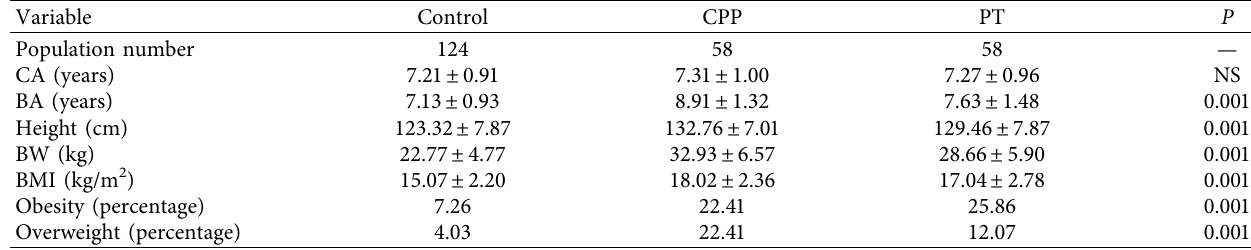
Table 1: The characteristics of patients in the precocious puberty groups and the control group.